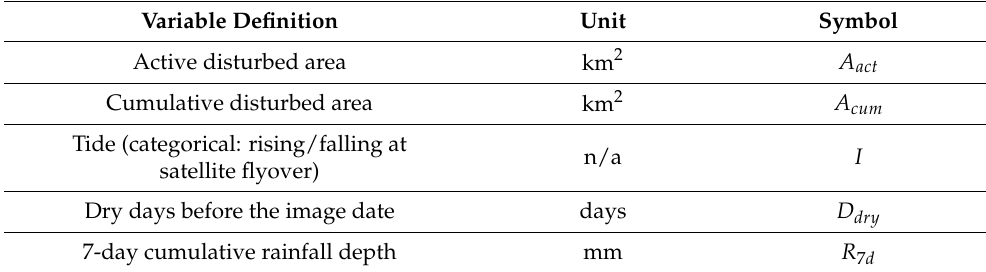
Table 8. Statistical models to predict the concentration of TSS in the five oyster-growing areas.